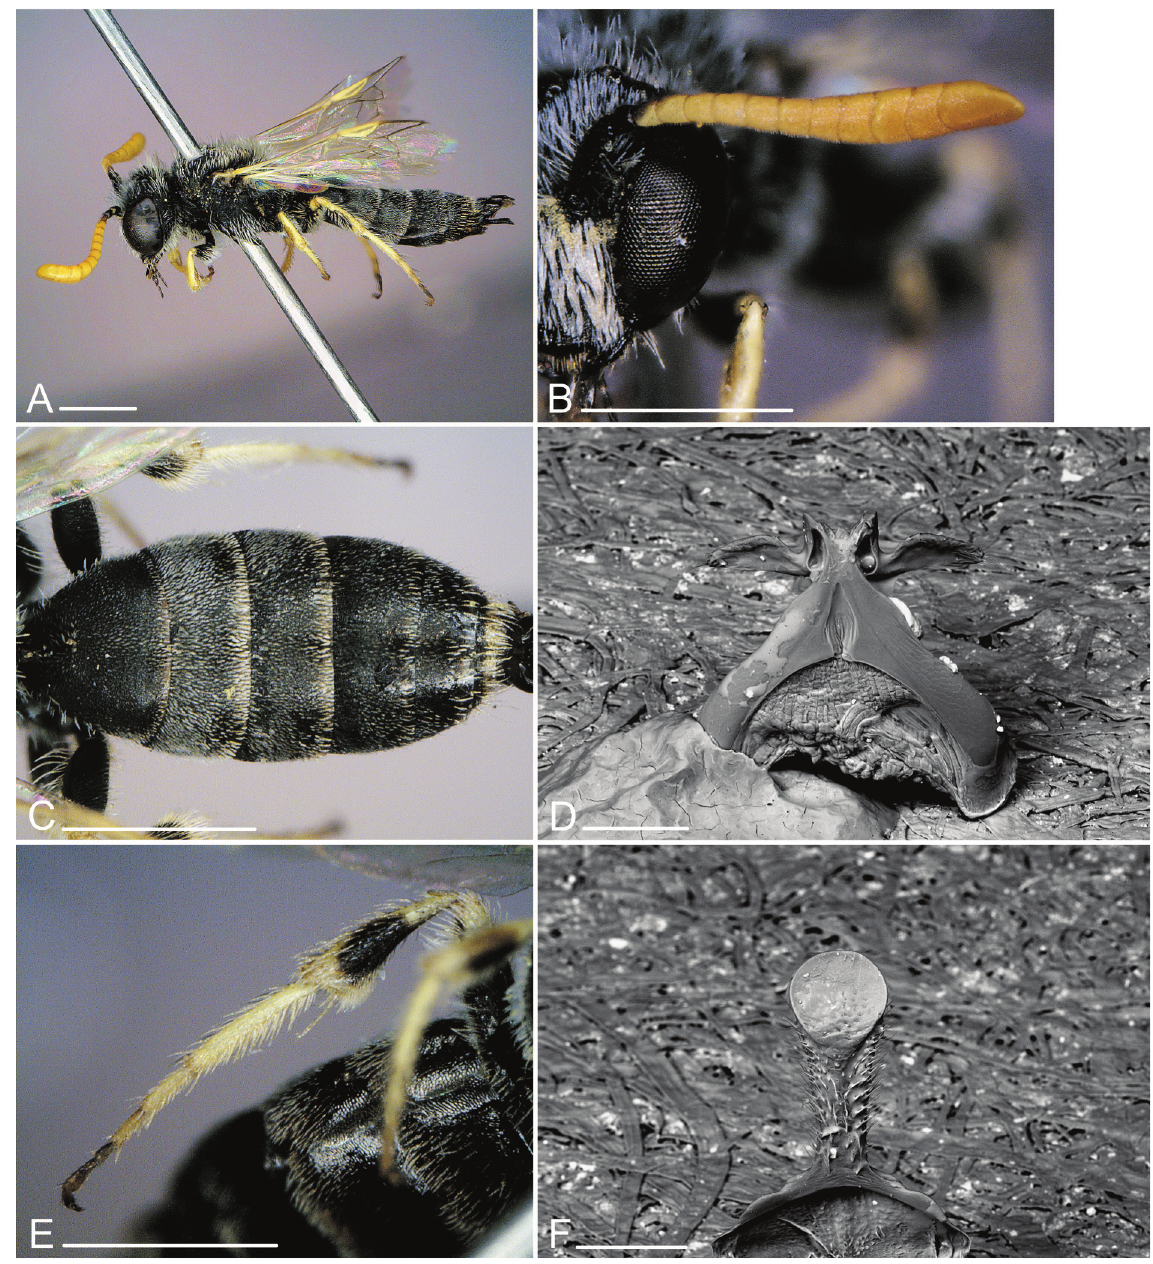
Fig. 12. Scrapter luteistigma sp. nov., ♂. A . Lateral view. B . Antenna. C . Metasoma (dorsal view). D . S7 (dorsal view, SEM). E . Hind tibia. F . S8, apical end (SEM). Scale bars: photos: 1 mm, SEM: 0.1